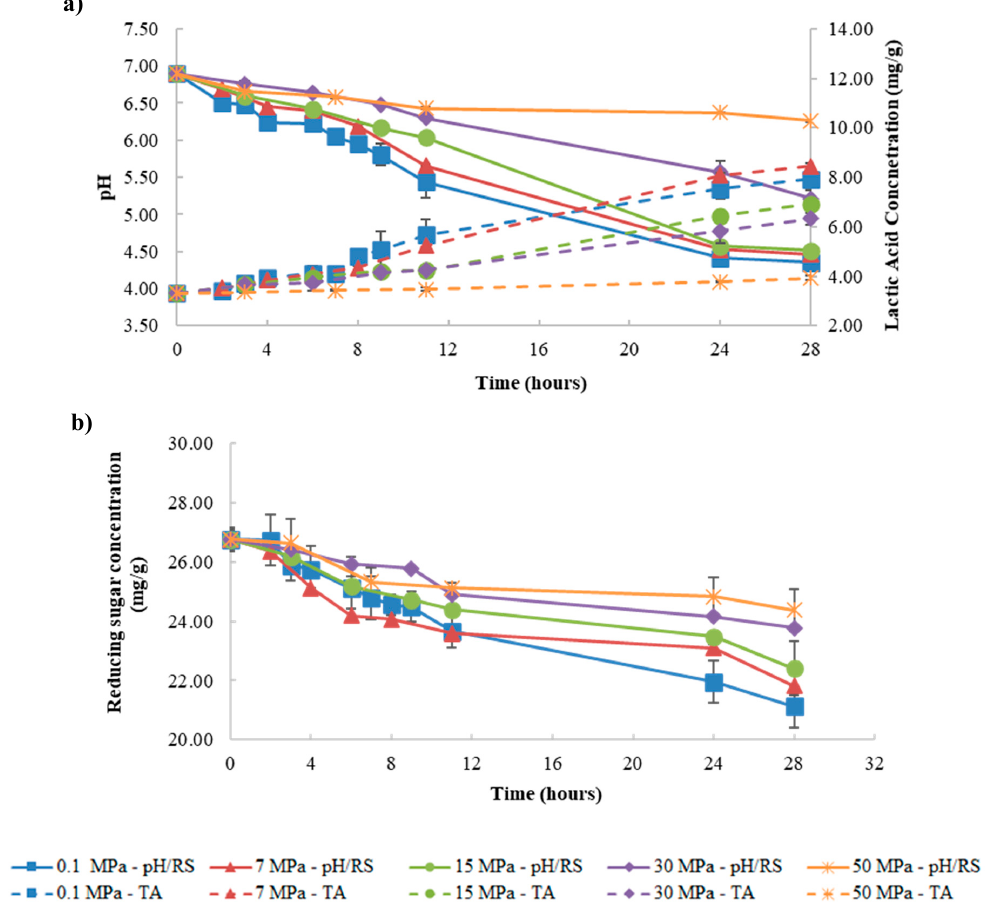
Figure 1. Variation of pH (solid lines) and titratable acidity (TA (broken lines), expressed as lactic acid concentration, mg / g) ( a ) and reducing sugar concentration (RS, mg / g) ( b ) during fermentation under different pressure conditions (0.1–50 MPa) at control temperature ( ≈ 17 °C).